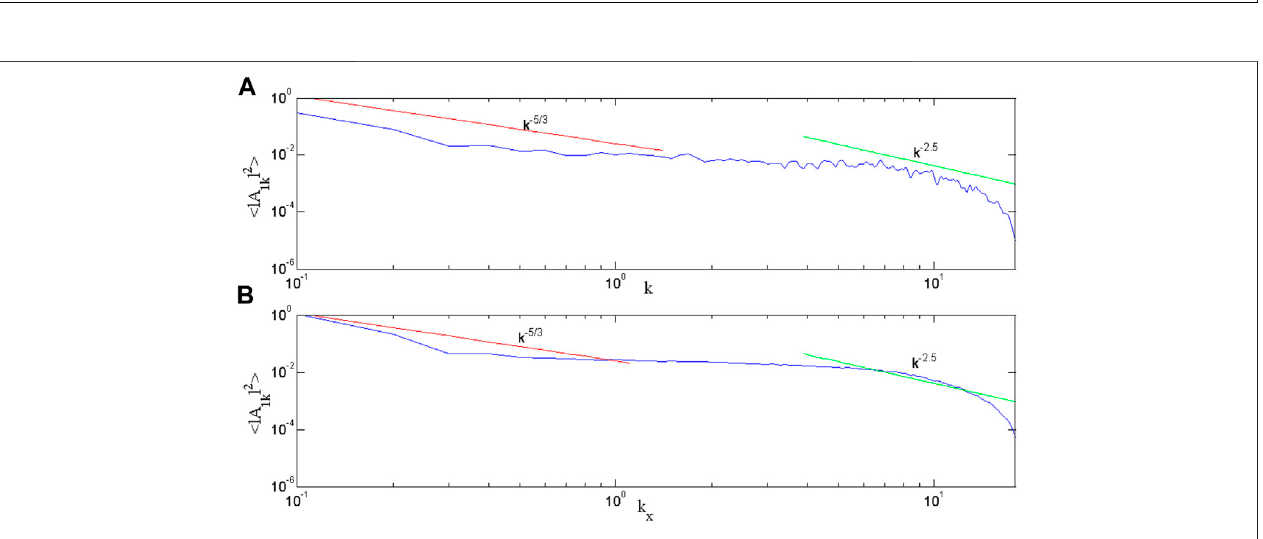
(cid:12)(cid:12)(cid:12)(cid:12)(cid:12)(cid:12)(cid:12) (cid:13) k 2 x + k 2 y (here k x and k y are normalized by λ i ) using nine spectra,